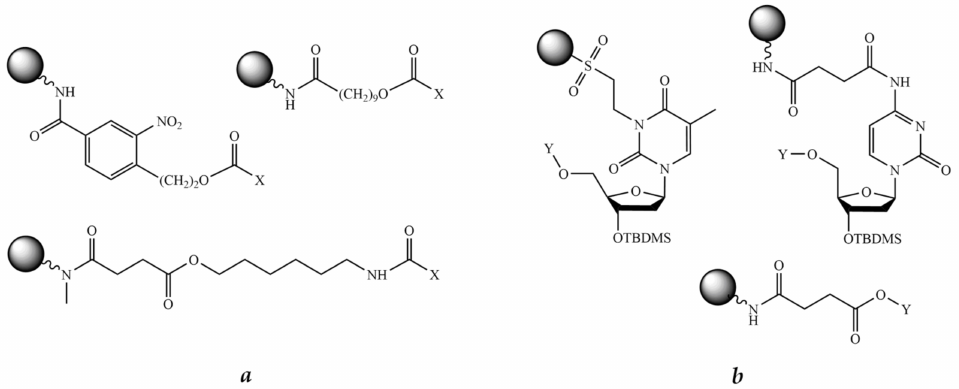
Figure 5. Bifunctional linkers used in the stepwise solid-phase synthesis approach: ( a ) starting with a peptide fragment via the C -terminus (X) and ( b ) starting with an oligonucleotide fragment (Y). TBDMS— t -butyldimethylsilyl protecting group.